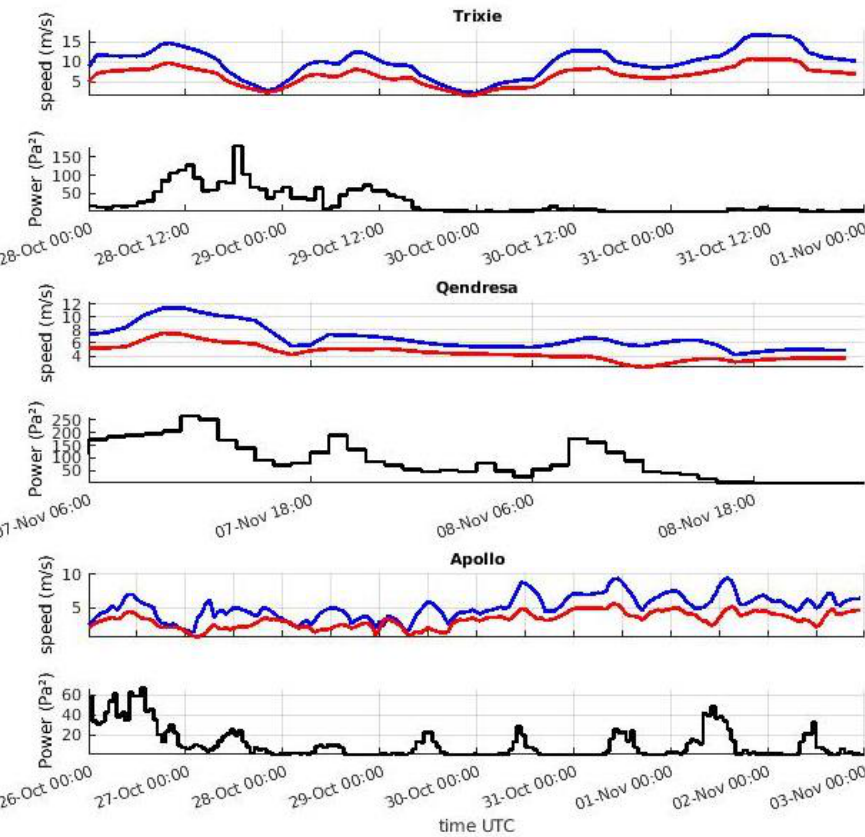
Figure 12. Time-series of ERA5 10-m wind (red line) and gusts (blue) ( m / s ) at IS48 during Trixie ( top ), Qendresa ( middle ), and Apollo ( bottom ), along with acoustic power integrated between 0.01 and 0.1 Hz (black line), as presented in Figure 3b and c for Trudy, for instance.